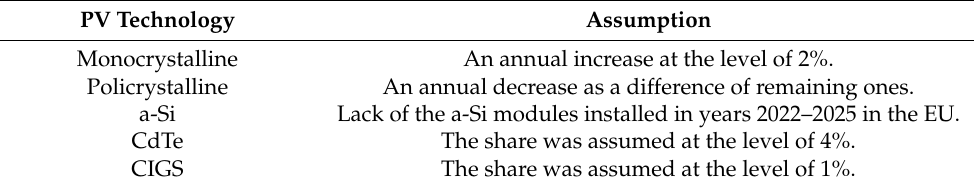
Table 5. Assumptions to the prediction of PV technologies shares in years